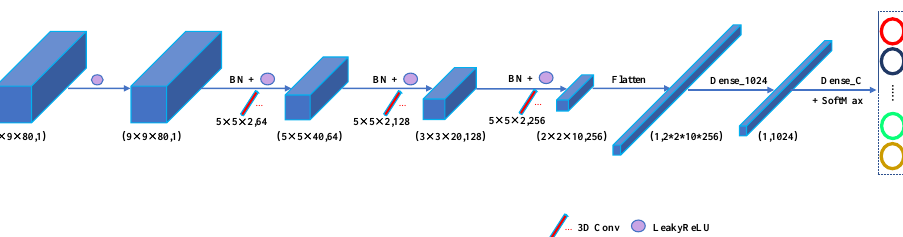
Figure 6. The Discriminator stuck with a classifier in CSSVGAN.